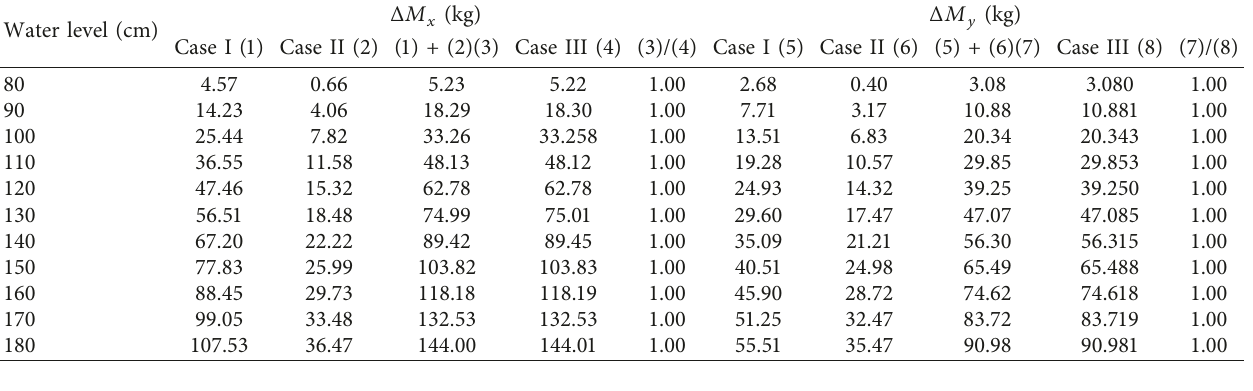
Table 7: HAM of the pier along the x -axis and y -axis in the three cases.